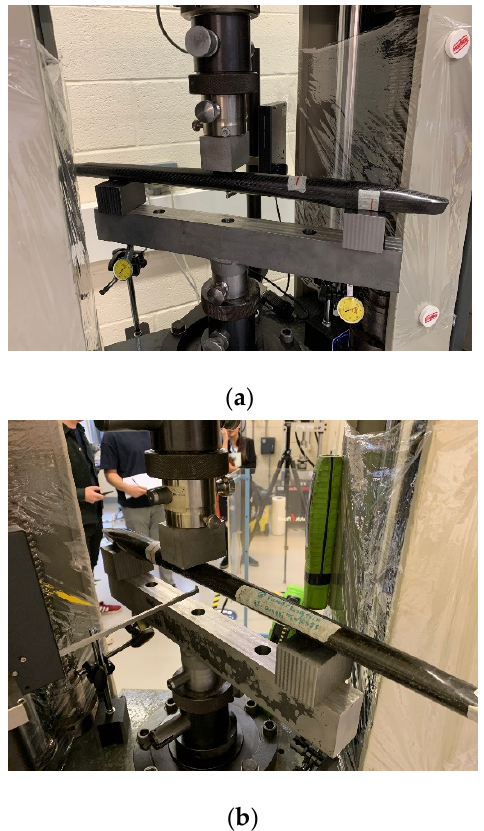
Figure 9. Flexural test set for the fuselage ( a ) CFRP fuselage, ( b ) QQF Fuselage.